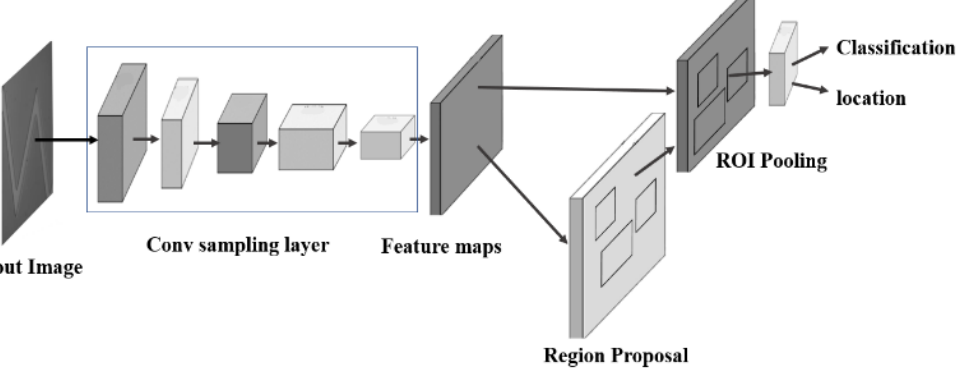
Figure 10. Schematic diagram of the structure of the two-stage detection network model.